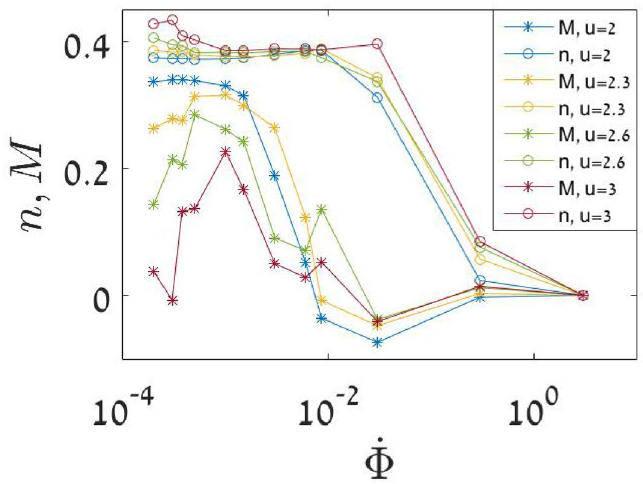
n M and at the end of the sweep process are (cid:31) (cid:30) (cid:31) (cid:30) n / N , M M / N ). := := M , which becomes prominent for (cid:31) (cid:30)